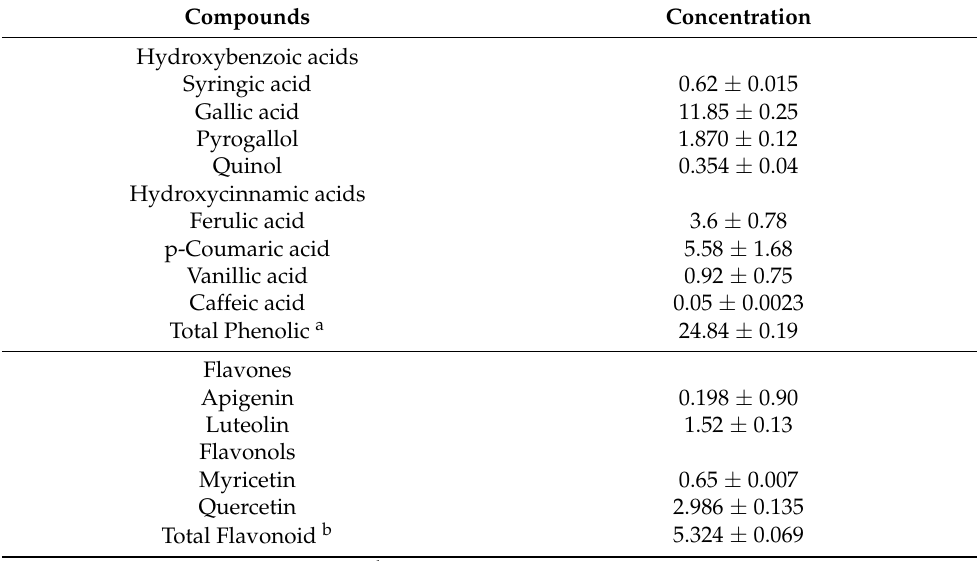
11.85 ± 0.25 1.870 ± 0.12 0.354 ± 0.04